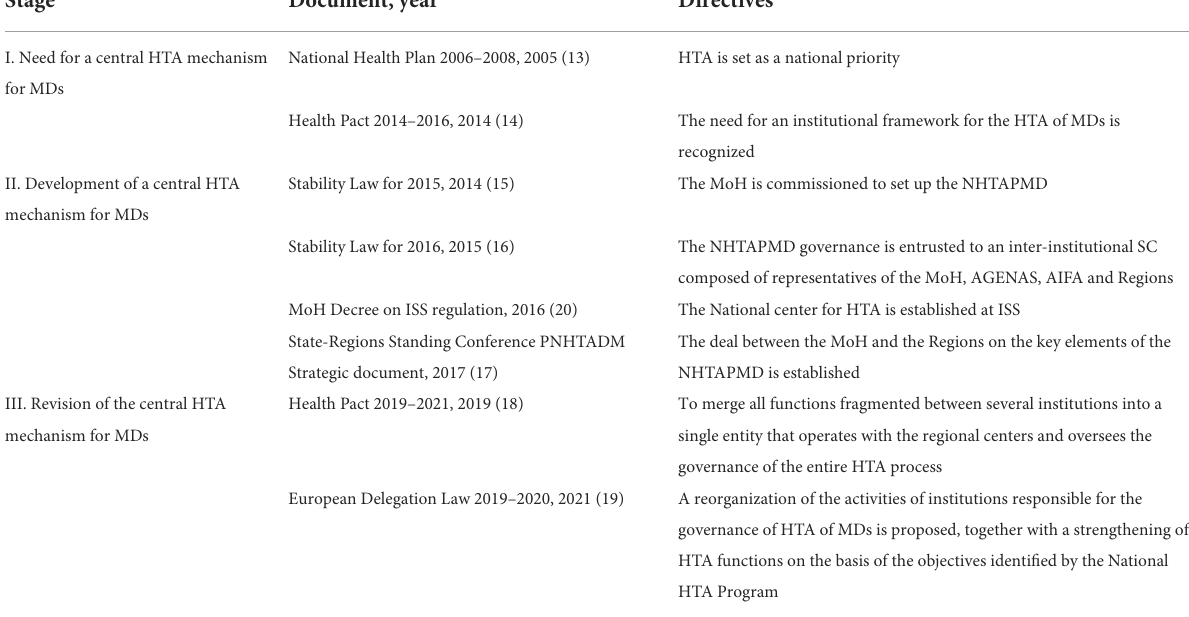
TABLE 2 Retrieved central regulatory documents and stages of national HTA